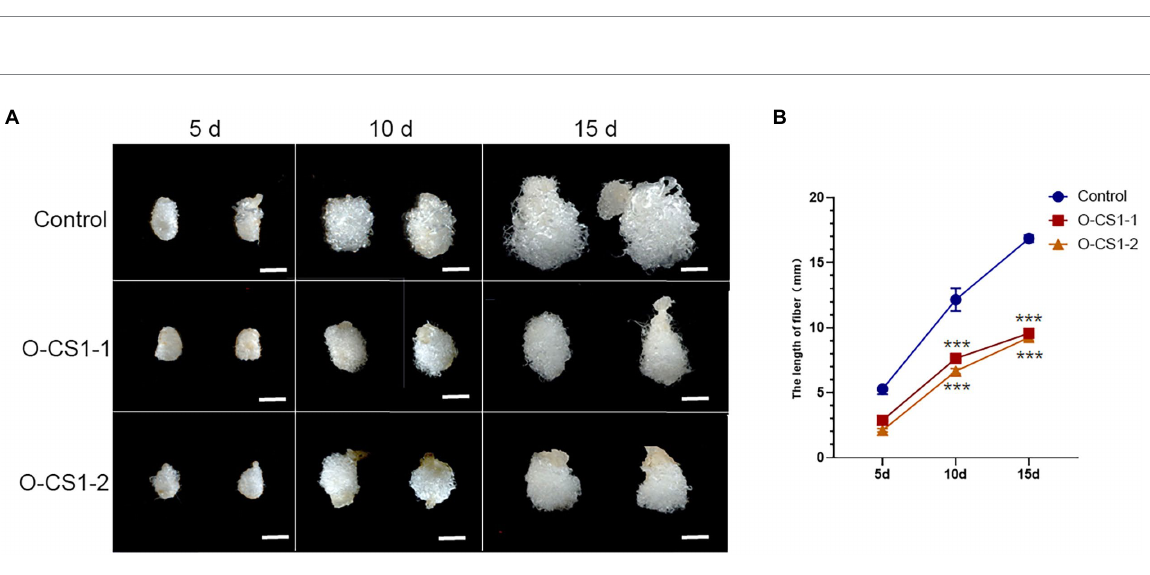
transgenic cotton ovules (Figure 7E). A total of 15 GluCer molecules and 3 GIPC molecules were detected, among which the content of 5 GluCer molecules increased significantly in transgenic cotton ovules (Figure 7F) and the content of 1